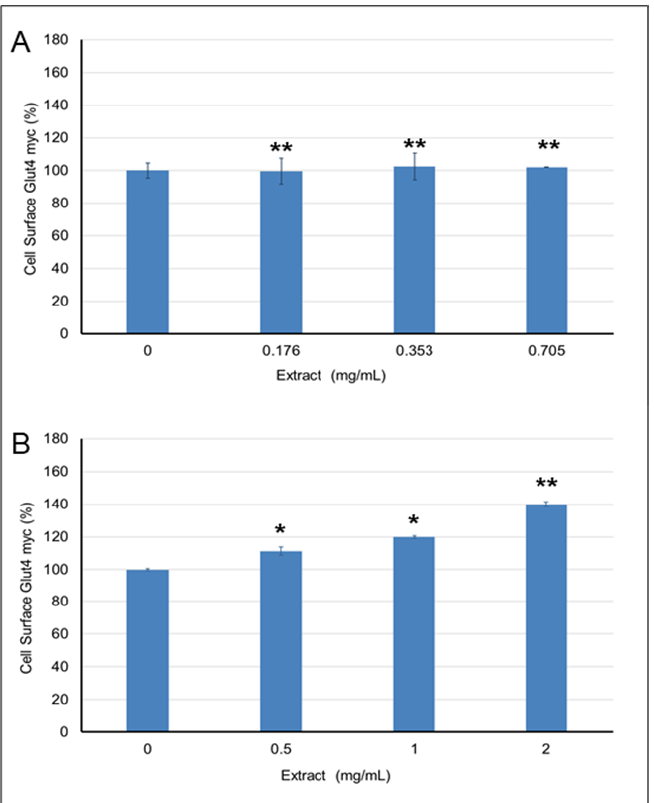
Figure 7. The effect of: ( A ) Pelargonium spp. and ( B ) Rhus coriaria extracts on GLUT4 translocation. The results represent a mean ± standard deviation of three experiments ( n = 3). One asterisk (*) indicates p < 0.05. Two asterisks (**) indicate p < 0.001.